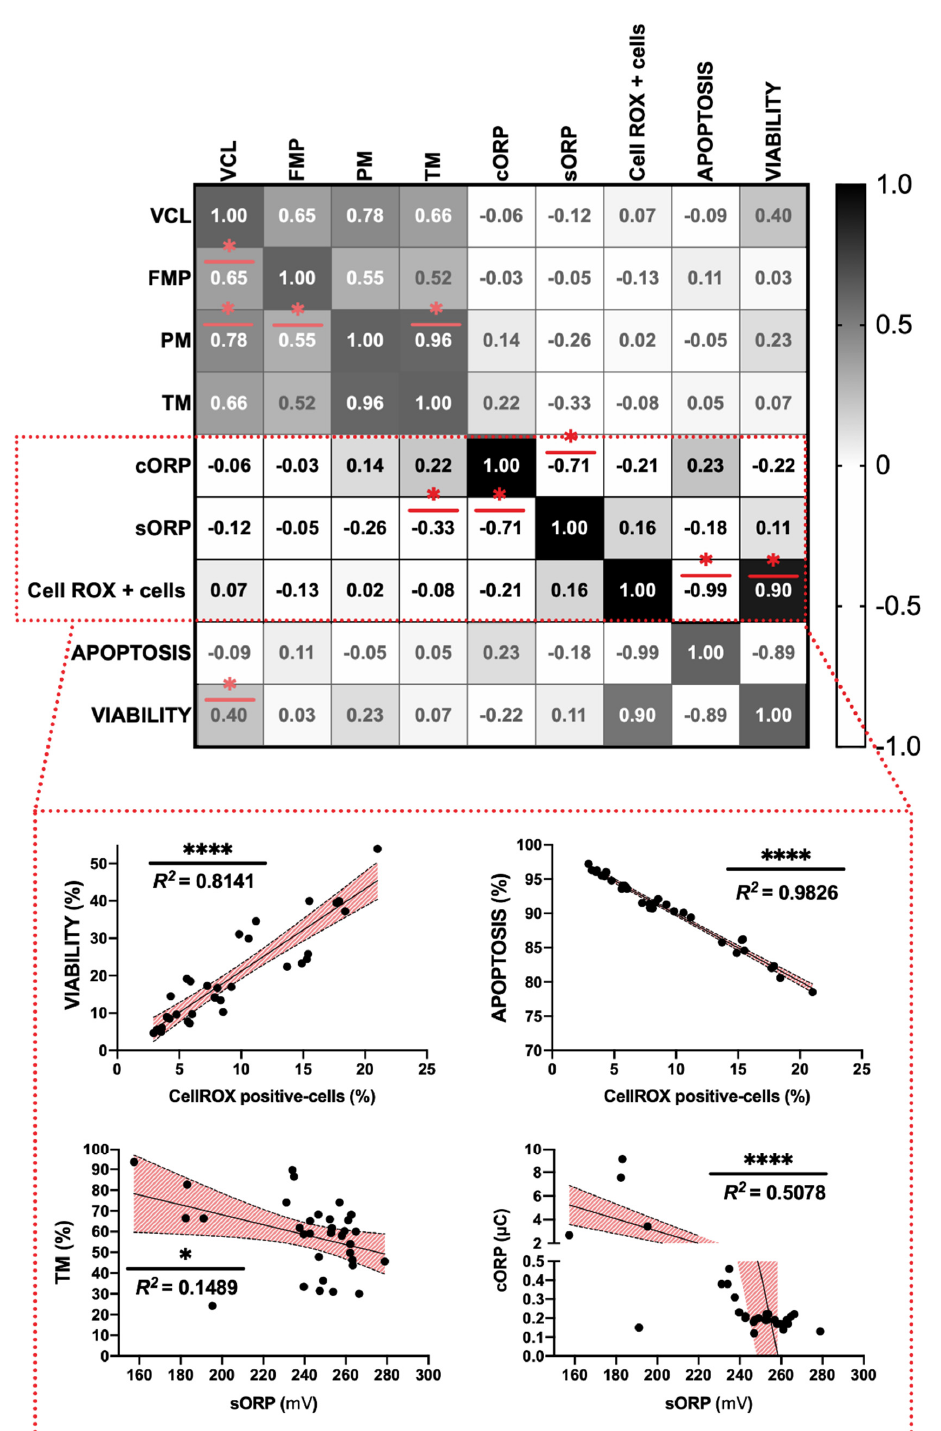
Figure 3. Correlation matrix of all sperm quality markers studied and individual significant correlations between some parameters. The experimental groups are included to calculate correlation matrix individual correlations. The R squared value between two parameters is represented in each cell and graph. In the correlation matrix, dark color indicates positive correlations and clear color indicates negative relationships. The color intensity represents the strength of the correlation between two sperm quality parameters. Asterisks show significant correlations ( p < 0.05) among in vitro sperm quality parameters. The number of asterisks (*) indicates the significance levels: one asterisk (*) indicates p < 0.05 and four asterisks (****) indicate p <